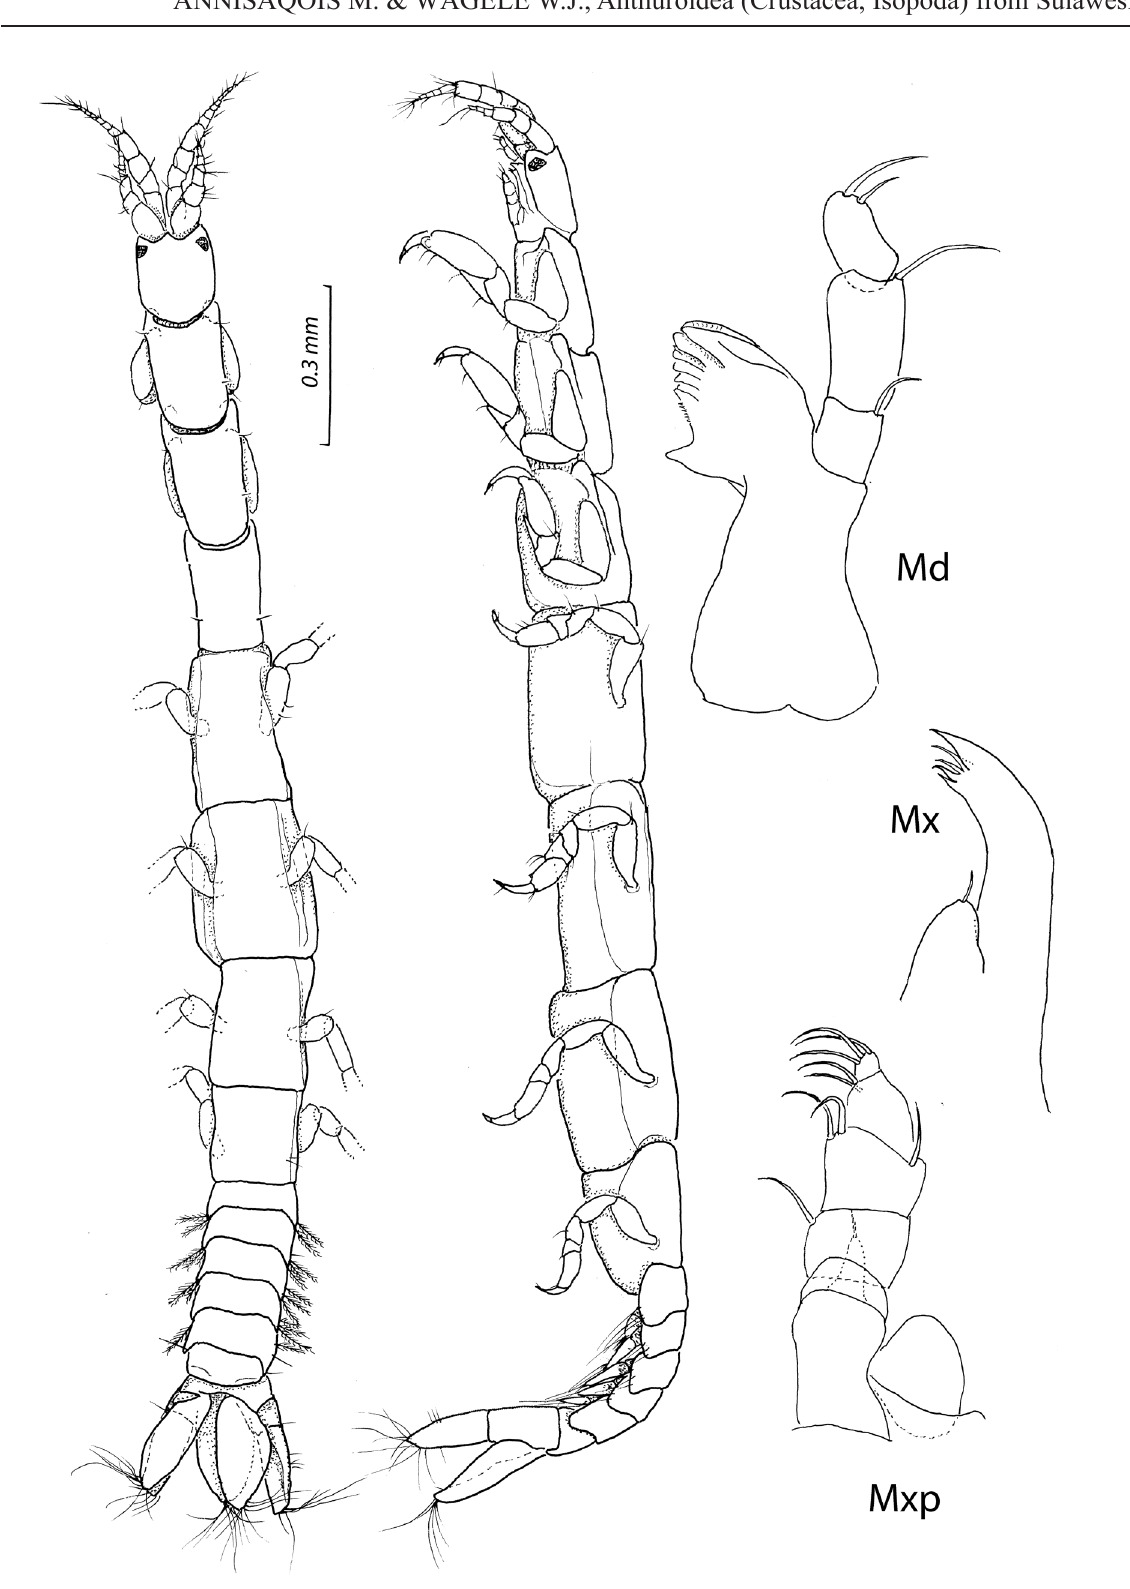
Fig. 6. Kupellonura indonesica sp. nov ., holotype, immature adult in dorsal and lateral view (2.5 mm) (MZB Iso 100). Abbreviations: Md = mandible; Mx = maxilla; Mxp =